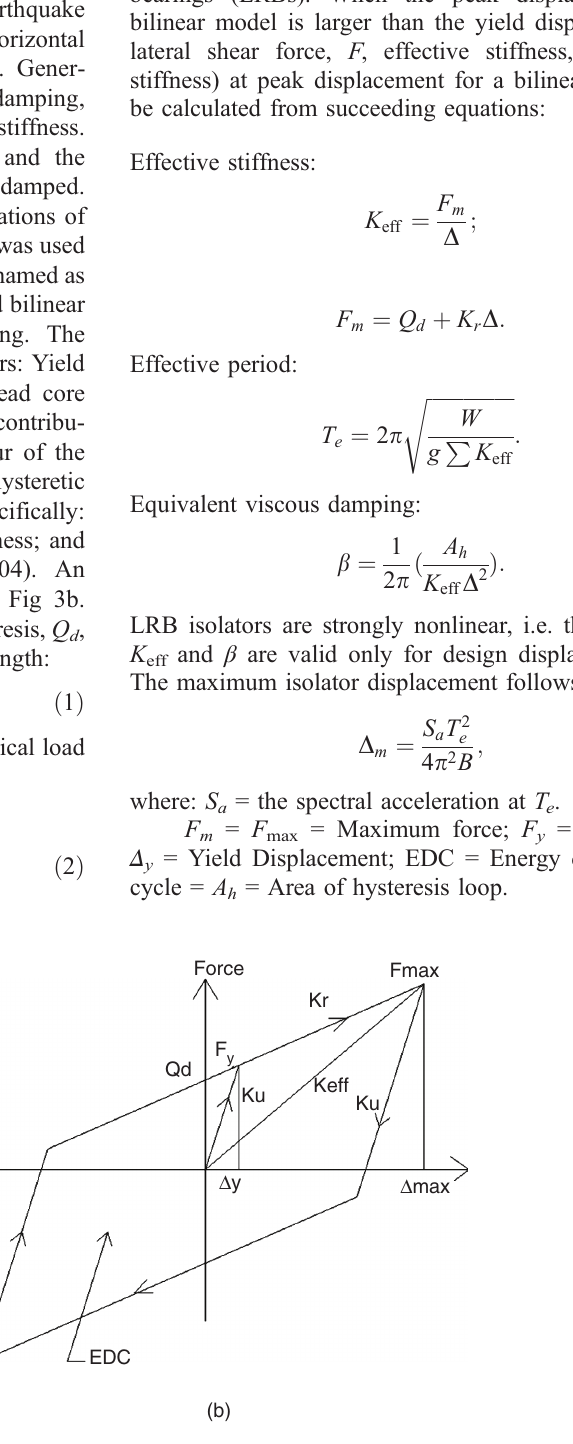
Fig. 3. LRB: Deformation pattern (a); idealised Bi-linear hysteretic model